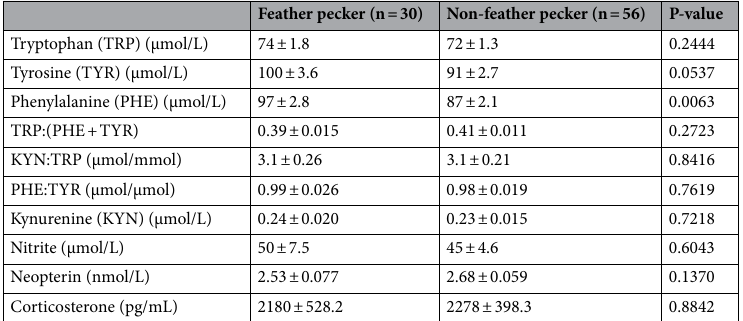
Feather pecker (n = 30) Non-feather pecker (n = 56)